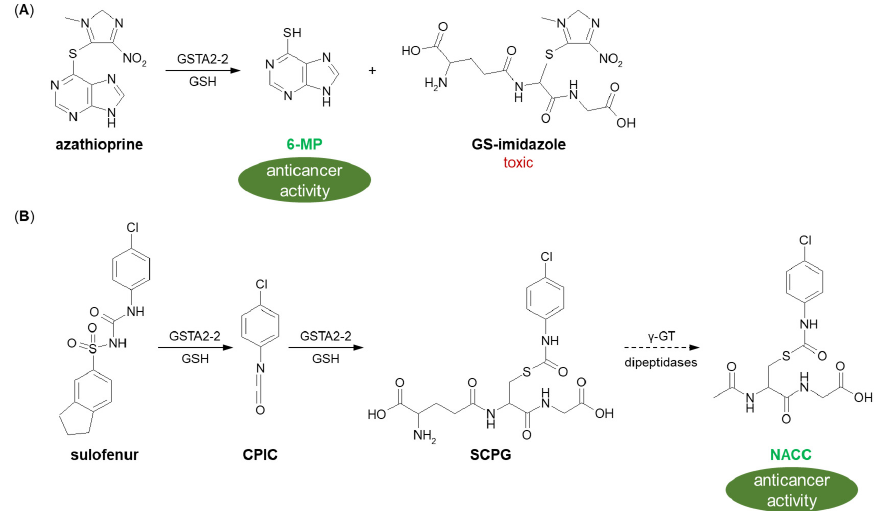
Figure 19. ( A ) Azathioprine [174] and ( B ) sulofenur [181] bioactivation to anticancer-active metabolites by GST-mediated GSH conjugation. 6-MP = 6-mercaptopurine; CPIC = p -chlorophenyl isocyanate; GSH = glutathione; GST = glutathione S-transferase; NACC = N-acetyl-S-( p -chlorophenylcarbamoyl) cysteine; SCPG = S-(N- p -chlorophenylcarbamoyl) GSH.